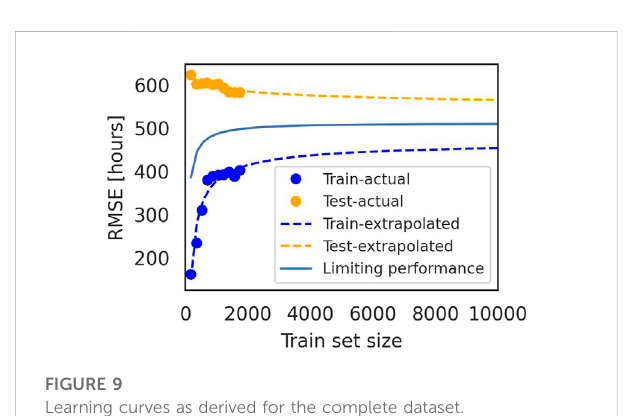
FIGURE 9 Learning curves as derived for the complete